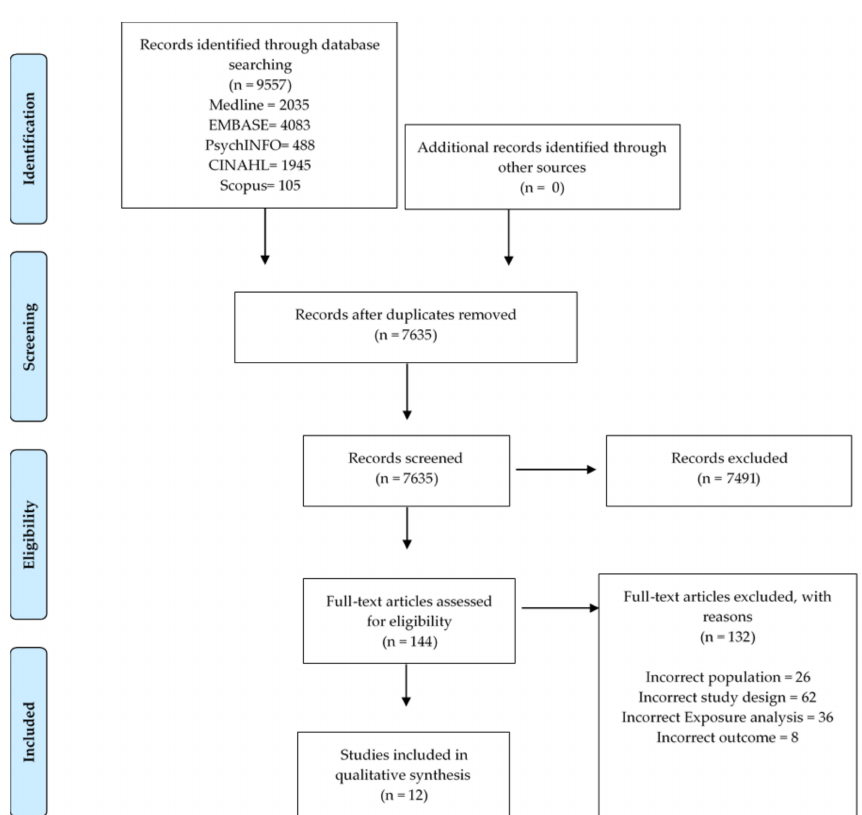
Figure 1. Flowchart of identification and screening process for selection of cohort studies exploring the association between fruit and vegetable intake and depressive symptoms in young people and adults aged 15–45